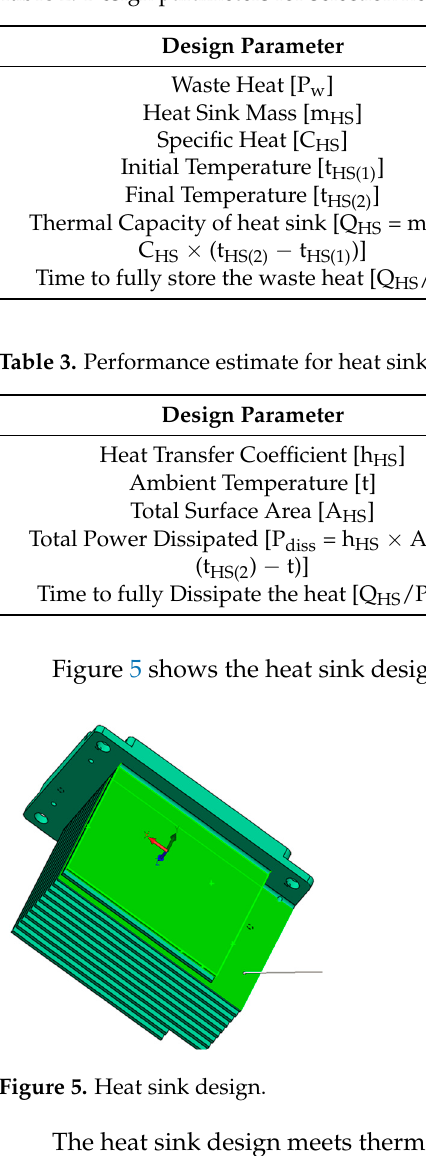
Table 2. Design parameters for selection heat sink and fan.